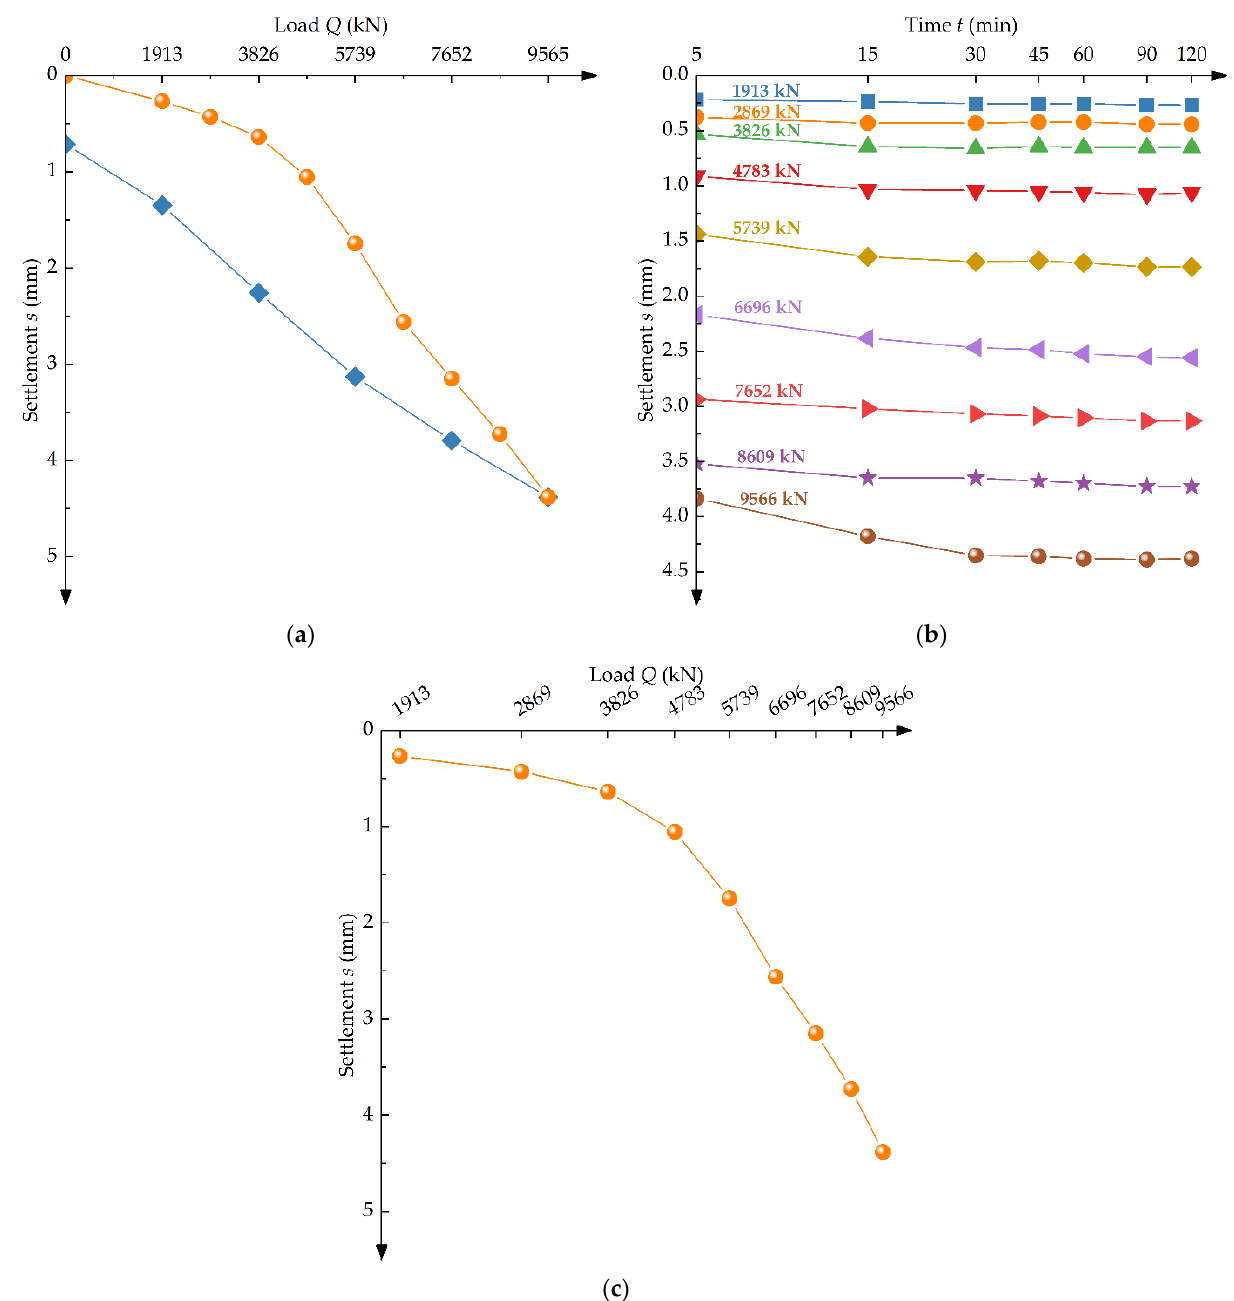
Figure 9. Vertical compressive static load test results of single pile No. 4: ( a ) load–settlement curve ( Q - S ); ( b ) settlement–time logarithm curve ( S -lg t ), and ( c ) settlement–load logarithm curve ( S -lg Q ).